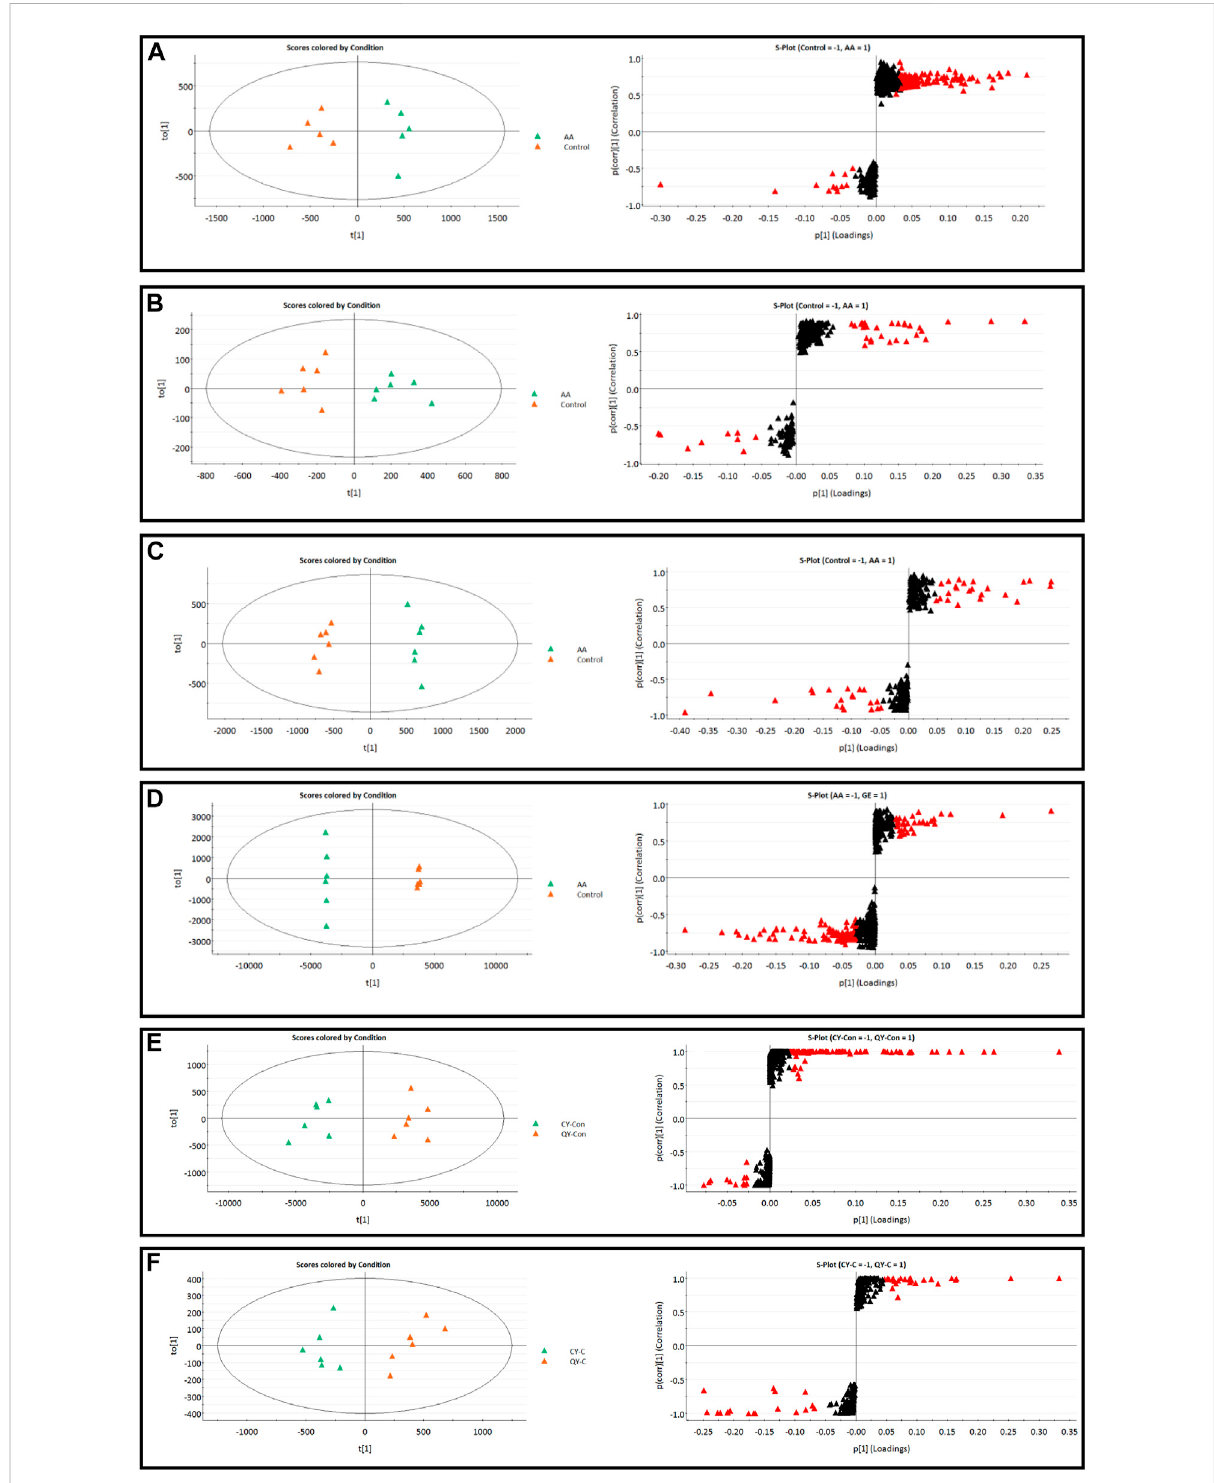
FIGURE 4 | OPLS-DA score plots and S-plots of synovial, serum and MH7A cells samples. (A) OPLS-DA model in ESI + mode corresponding to synovial sample (AA vs. C: R 2 Y = 0.93, Q 2 = 0.85); (B) OPLS-DA model in ESI − mode corresponding to synovial sample (AA vs. C: R 2 Y = 0.82, Q 2 = 0.78); (C) OPLS-DAmodelinESI + modecorrespondingtoserumsamples(AAvs.C:R 2 Y=0.99,Q 2 =0.96); (D) OPLS-DAmodelinESI − modecorrespondingto serum samples (AA vs. C: R 2 Y = 0.98, Q 2 = 0.94); (E) Corresponding to OPLS-DA model in ESI + mode of MH7A sample (CY-C vs. QY-C: R 2 Y = 0.85, Q 2 = 0.91); (F) Corresponding to OPLS-DA model in ESI − mode of MH7A sample (CY-C vs. QY-C: R 2 Y = 0.84, Q 2 = 0.88); the variable with VIP > 1.0 was highlighted with a red frame in the S-plots of each